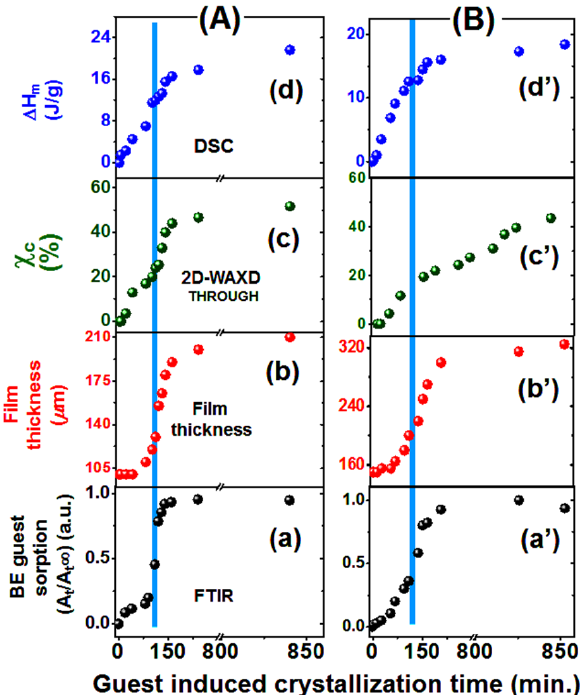
Figure 5. Kinetics of phenomena associated with room-temperature guest-induced crystallization of amorphous PPO films, with thickness of 100 µ m ( A ) and 150 µ m ( B ): ( a , a’ ) BE guest sorption; ( b , b’ ) film thickness; ( c , c’ ) crystallinity index by WAXD ( χ c ); ( d , d’ ) melting enthalpy ( ∆ H m ). The blue vertical bar indicates the time of inflection of the S-shaped curve describing guest sorption, which can be taken as a measure of the time needed for film plasticization.